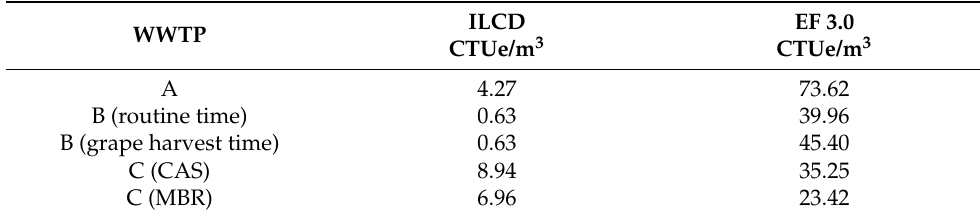
Table 3. Impact on freshwater ecotoxicity category: values of CTUe/m 3 for the studied WWTPs.